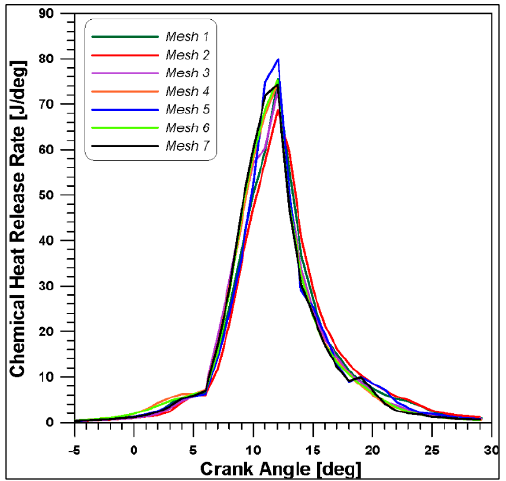
Figure 10. Rate of heat release for the different meshes.